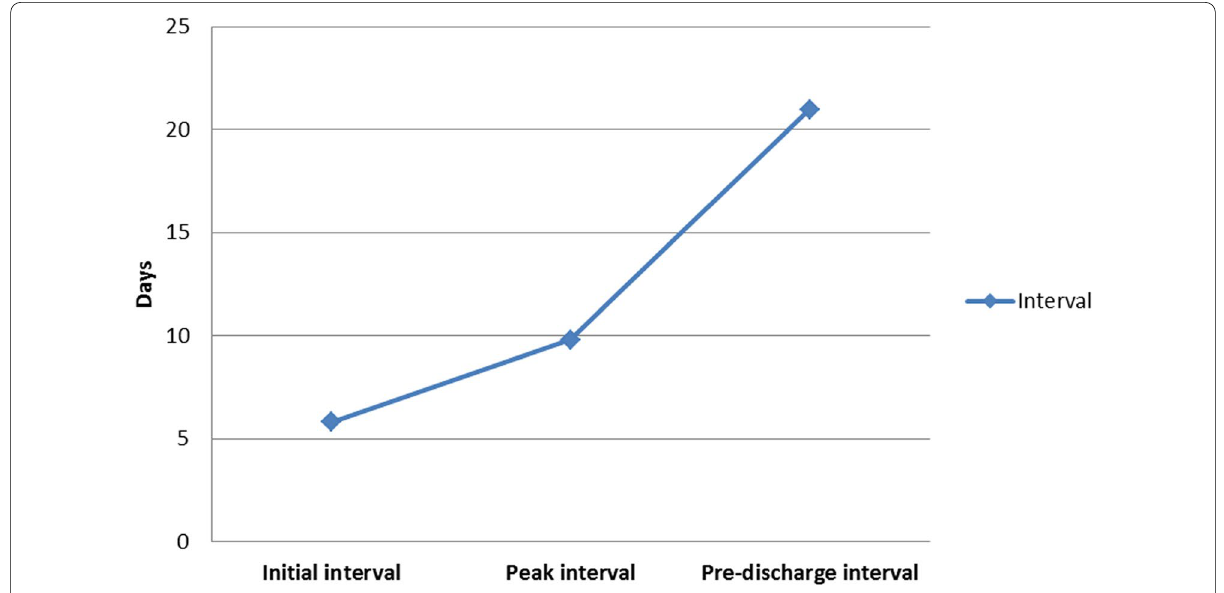
Fig. 2 The intervals between the onset of symptoms and initial CT, peak CT, and pre‑discharge